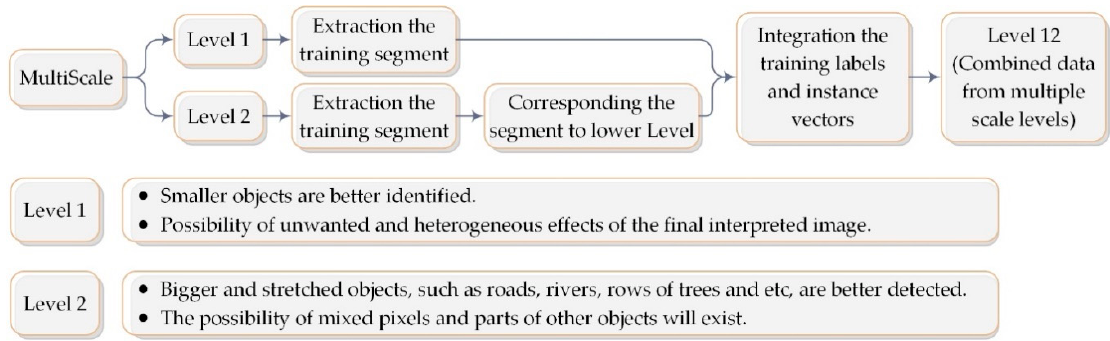
Figure 3. Training data sampling at different levels of scale.